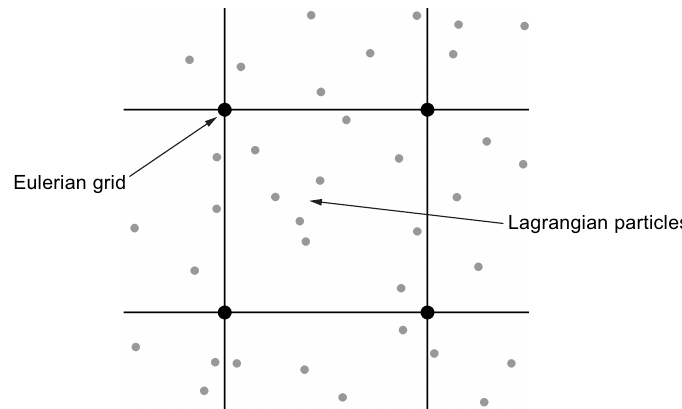
Figure 2. Q 1 Q 1 -based Eulerian grid combined with Lagrangian